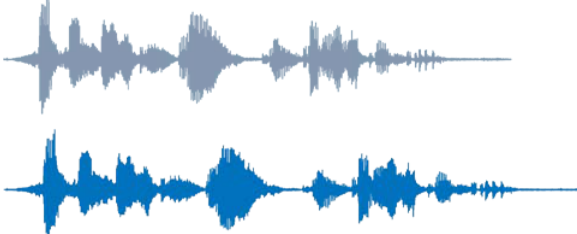
Figure 6 shows an example of visual synchronization implemented by duplicating and dropping video